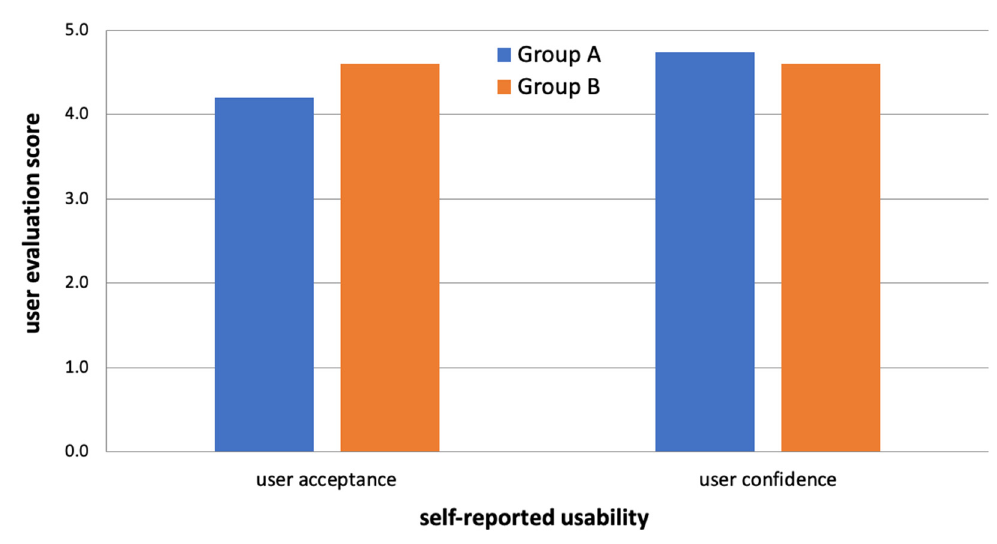
Figure 7. Participants’ self ‐ reported acceptance and confidence about their constructed personas.